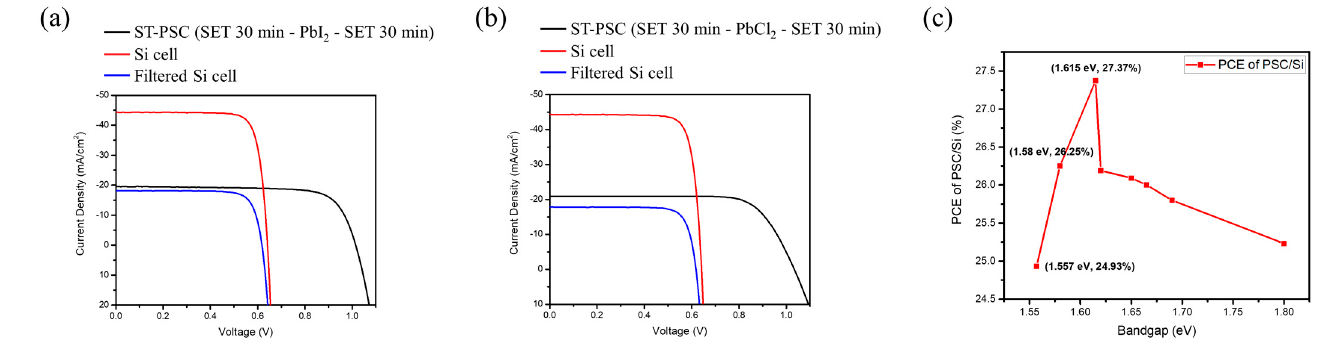
Figure 8. J–V curves of semitransparent PSC, and silicon solar cell with and without the semi- transparent PSC filter ( a ) ST-PSC (SET 30 min-PbI 2 -SET 30 min). ( b ) ST-PSC (SET 30 min-PbCl 2 -SET